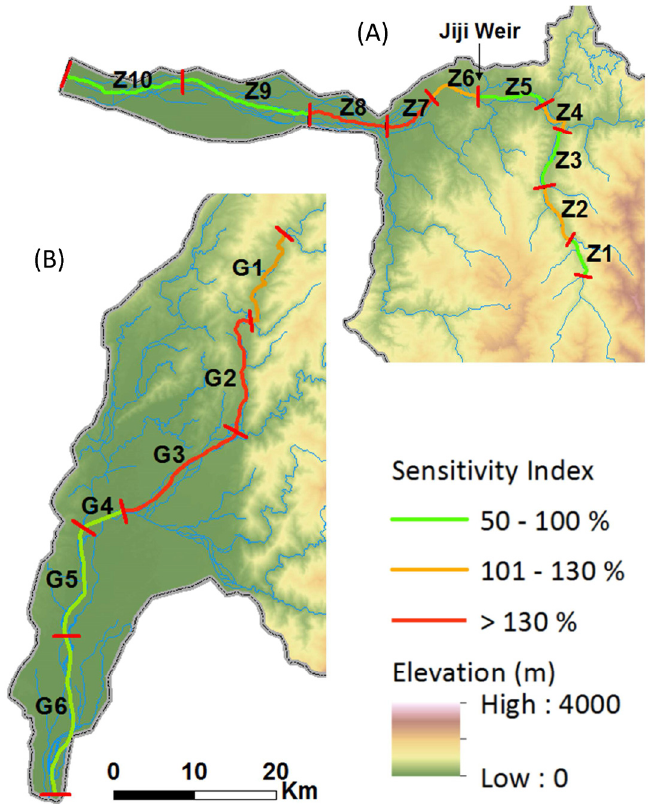
Figure 6. The downstream patterns of the Sensitivity Index along the Zhuoshui ( A ); and the Gaoping Rivers ( B ). Rivers ( B